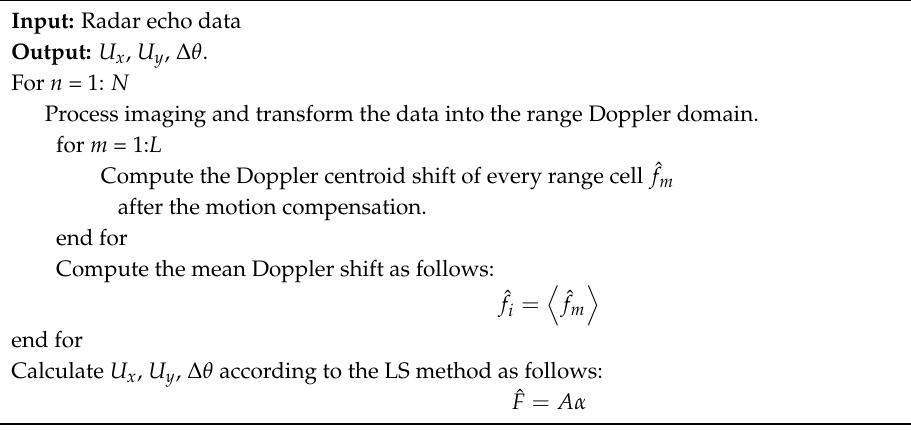
Algorithm: The sea surface current